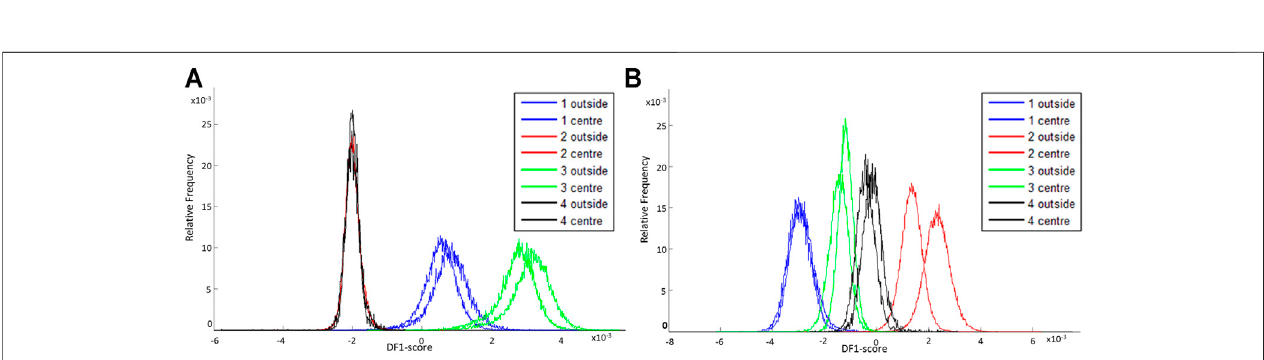
FIGURE 4 | DF-1 scores for comparison of the intra-variability of fracture hematoma for negative and positive ion mode. The DF-1 score explains the biggest variance in the data set as determined by a PCA-LDA of the mass spectra of the outside and center sections of different porcine fxh. (A) DF-1 score for the outside and center sections of four porcine fxh in negative ion mode. (B) DF-1 score for the outside and center sections of four porcine fxh in positive ion mode.